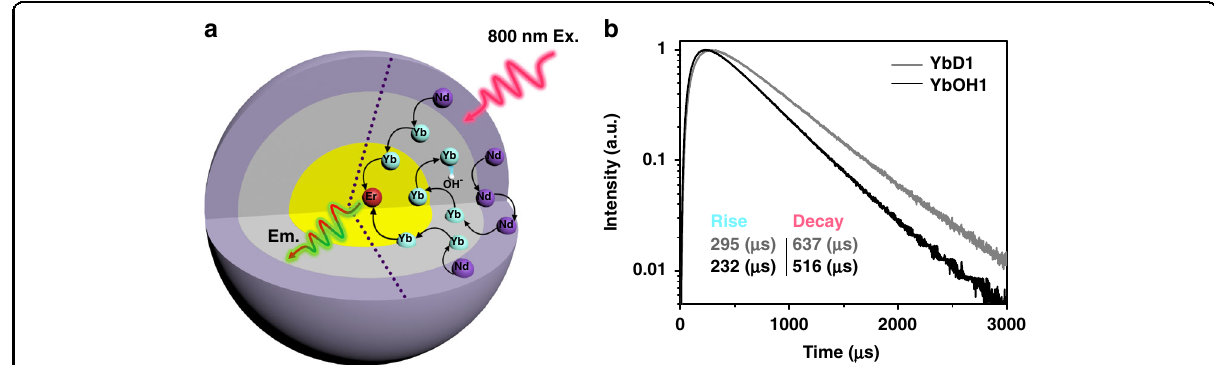
Fig. 5 Schematic illustration and UC emission dynamical curves of the Yb,Er@Yb(OH) x @Nd structure. a The UC process in the Yb,Er@Yb (OH) x @Nd structure, in which the three basic processes (photon absorption (800 nm), energy migration, and UC emission) are spatially separated. Black curve arrows represent the energy transfer steps affected by the OH − quenching. b Under 800 nm excitation, the UC emission (540 nm) dynamical processes of different middle layer samples: without OH − (YbD1) and with OH − (YbOH1). The middle layer thicknesses are ca. 2.3 nm for YbD1 and